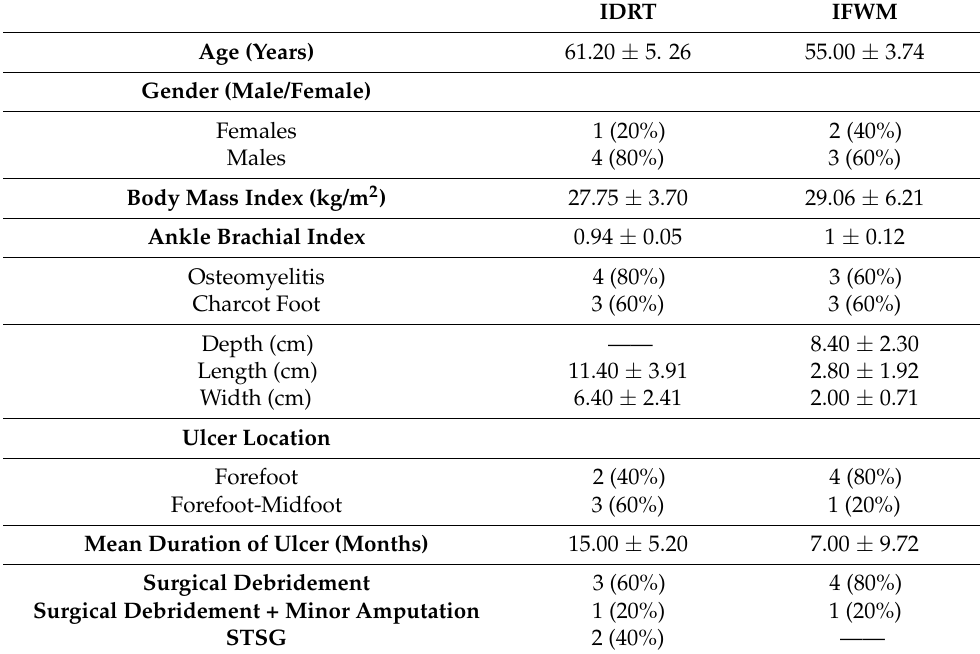
Table 3. Baseline demographics and clinical characteristics. IDRT: Integra dermal regeneration